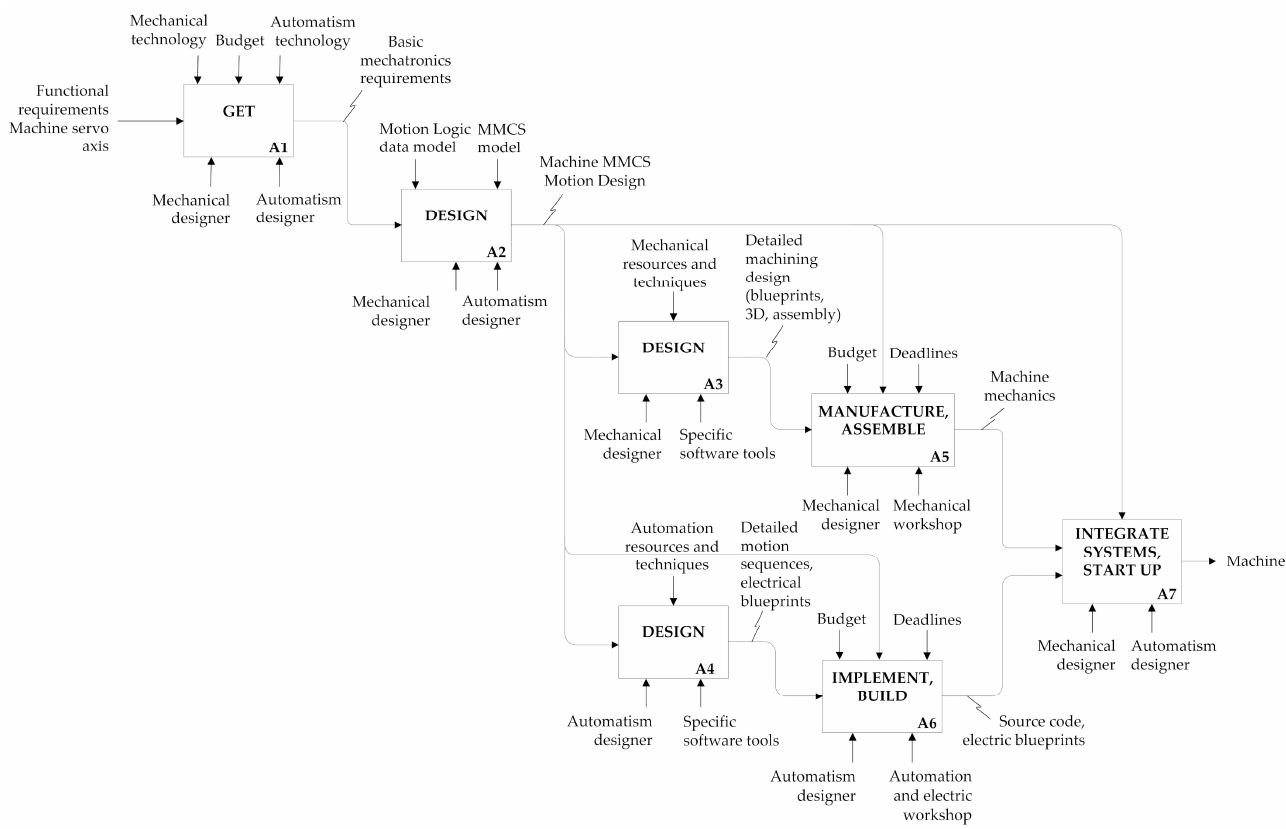
Figure 5. Servo axes machine design process with mechanical and motion control schematics (MMCS) model support.